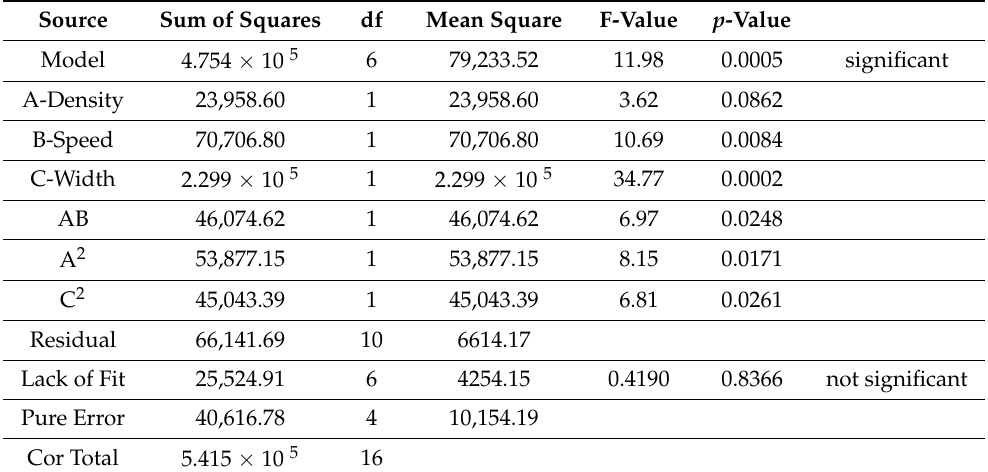
Table 4. ANOVA for the reduced quadratic model of the shear load.